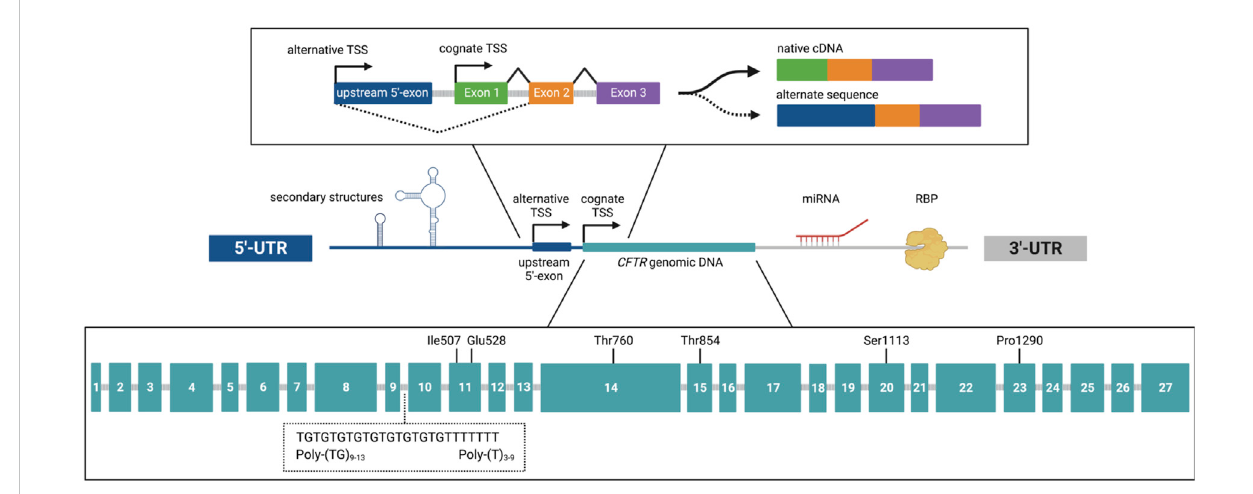
FIGURE 2 Major contributors to CFTR mRNA structure, abundance, and utilization. In the 5 ′ -untranslated region (UTR), RNA secondary structures inhibit translationinitiationandmRNAstability.Upstream5 ′ -exonsintroducedbyanalternativetranscriptionalstartsite(TSS)demonstrateskippingofexon-1 via directsplicingtoexon-2(upperpanel).The3 ′ -UTRfacilitatesenhancedorreducedCFTRmRNAexpressionthroughinteractionofRNA-binding proteins (RBPs) with cytosine repeats, poly-uracil tracts, or AUUUA motifs. Engagement of miRNAs with the 3 ′ -UTR also diminishes CFTR transcript abundance. Within the gene body, synonymous single nucleotide polymorphisms at residues Ile507, Glu528, Thr760, Thr854, Ser1113, and Pro1290 confer alterations to CFTR mRNA secondary structure, splice forms, and translation ef fi ciency (lower panel). In addition, extended repeats of thymidine (9T) and/or thymidine-guanine (13TG) in intron 9 induce alternative splicing and skipping of exon-10. Image was generated using